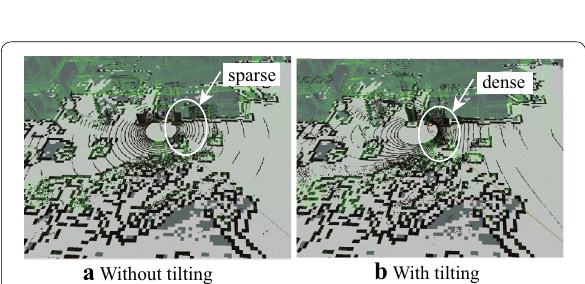
Fig. 14 Scan lines (black lines) with and without tilting the omni-directional laser scanner